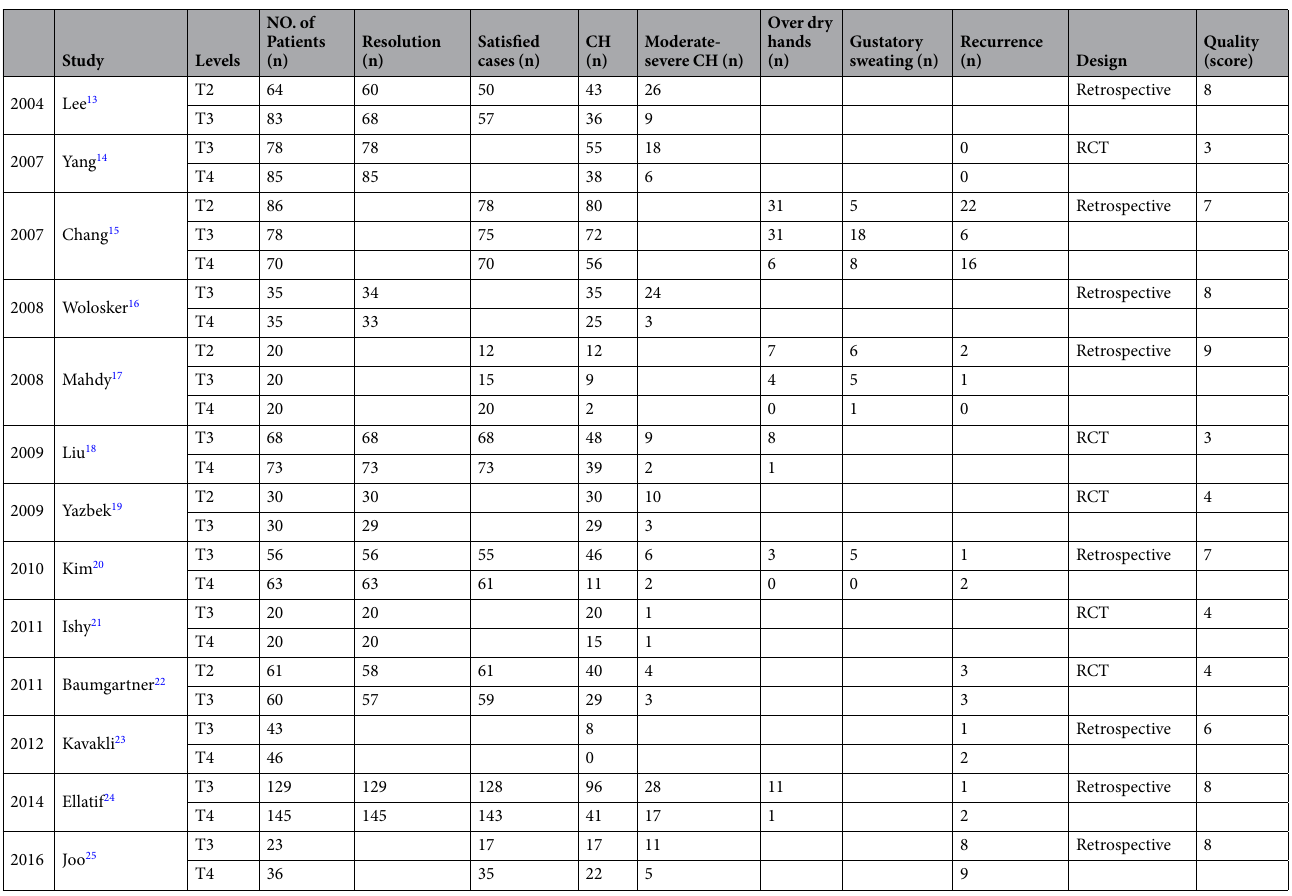
Table 1. Summary of the 13 studies included in the present